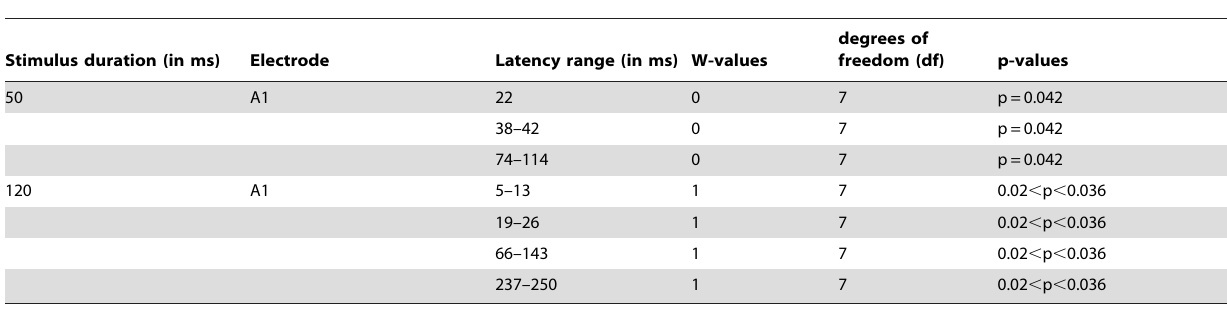
Table 1. Significant differences between standard and deviant deflections with respect to stimulus duration.